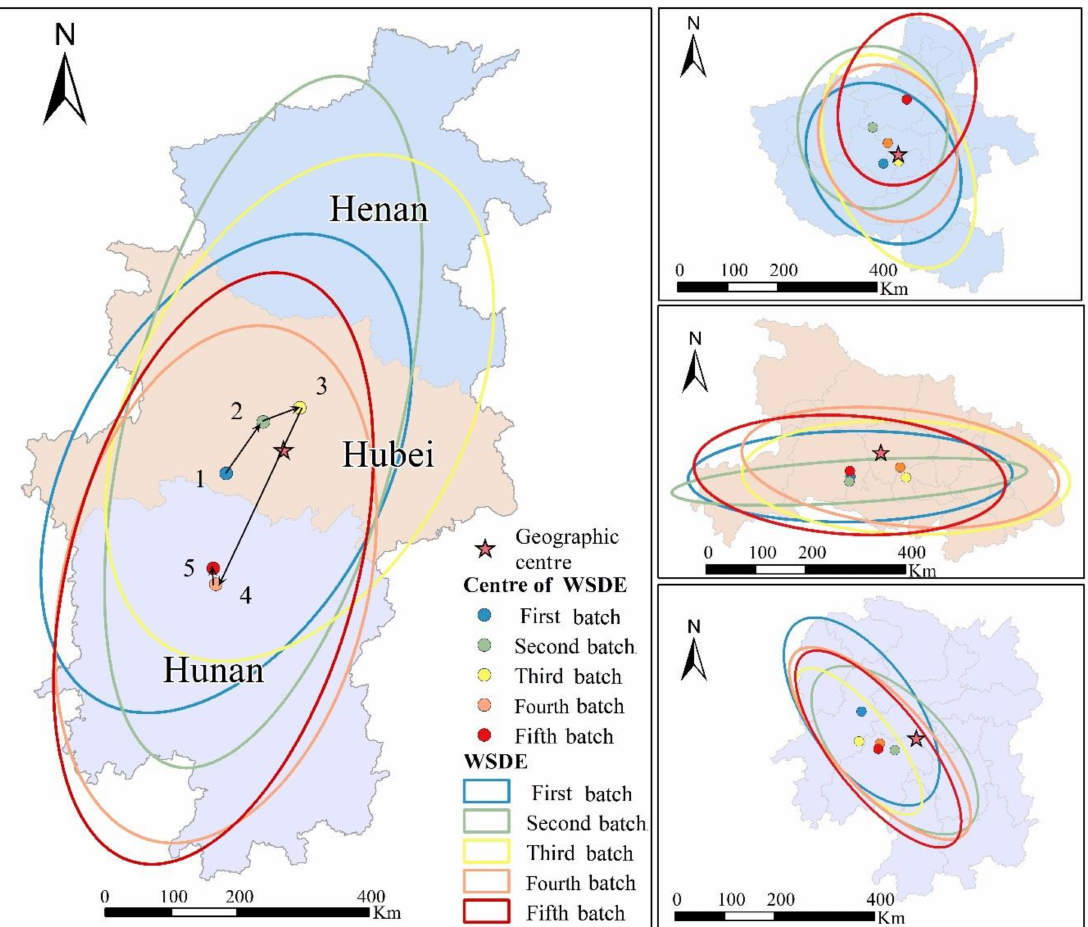
Figure 7. The WSDEs and the trajectories of centers for Central China and subordinate